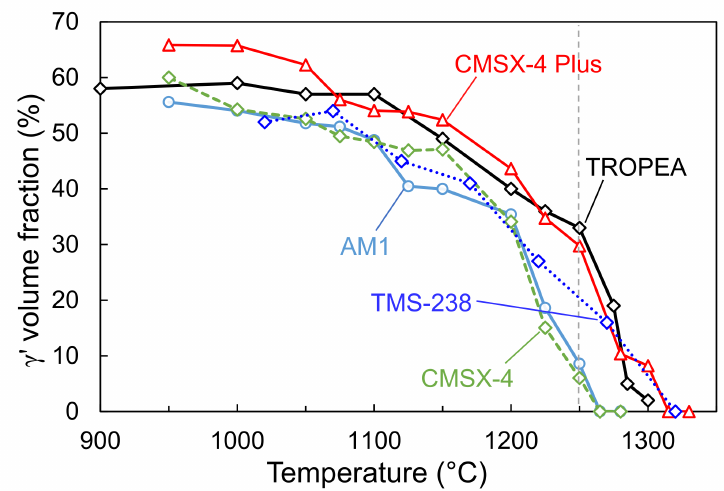
Figure 13. Relationship between γ (cid:48) volume fraction at thermodynamical equilibrium and temper- ature in Ni-based SX superalloys AM1, CMSX-4, CMSX-4 Plus, TMS-238, and TROPEA. Data for CMSX-4, CMSX-4 Plus, and TROPEA are taken from a reference [33]. The vertical dotted line is drawn to show 1250 ◦